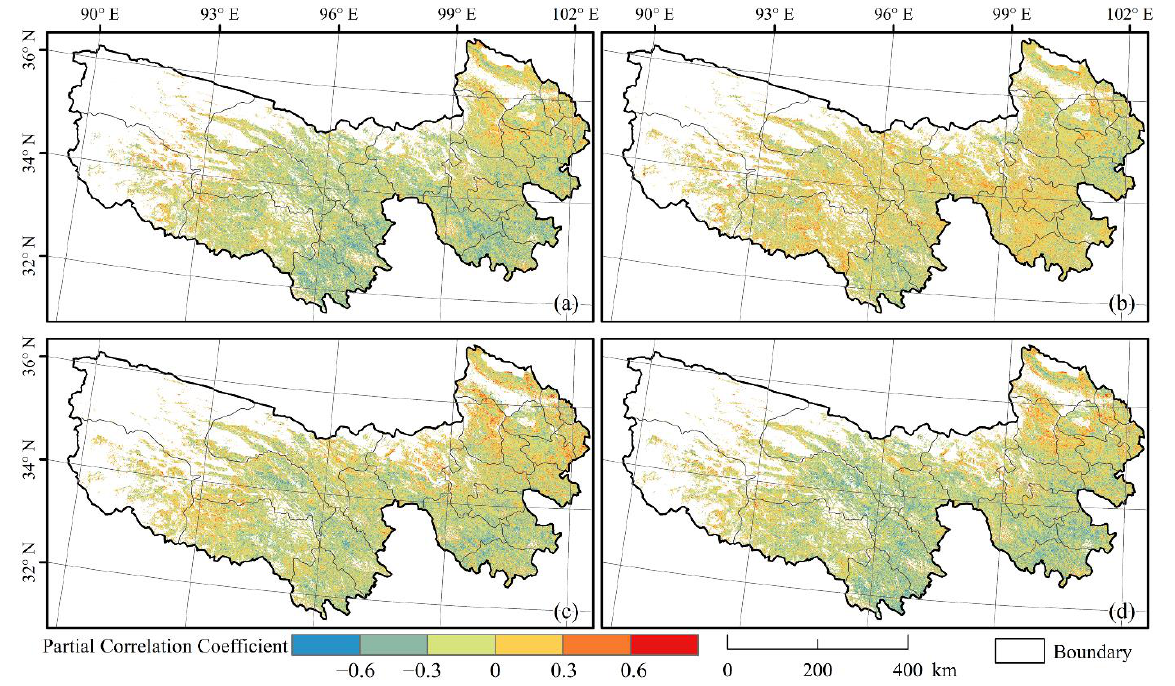
Figure 8. Spatial distribution of the partial correlation coefficients between the SOS of the vegetation and air temperature in March ( a ), April ( b ), May ( c ) and March–May ( d ) in the Three-River headwaters region.